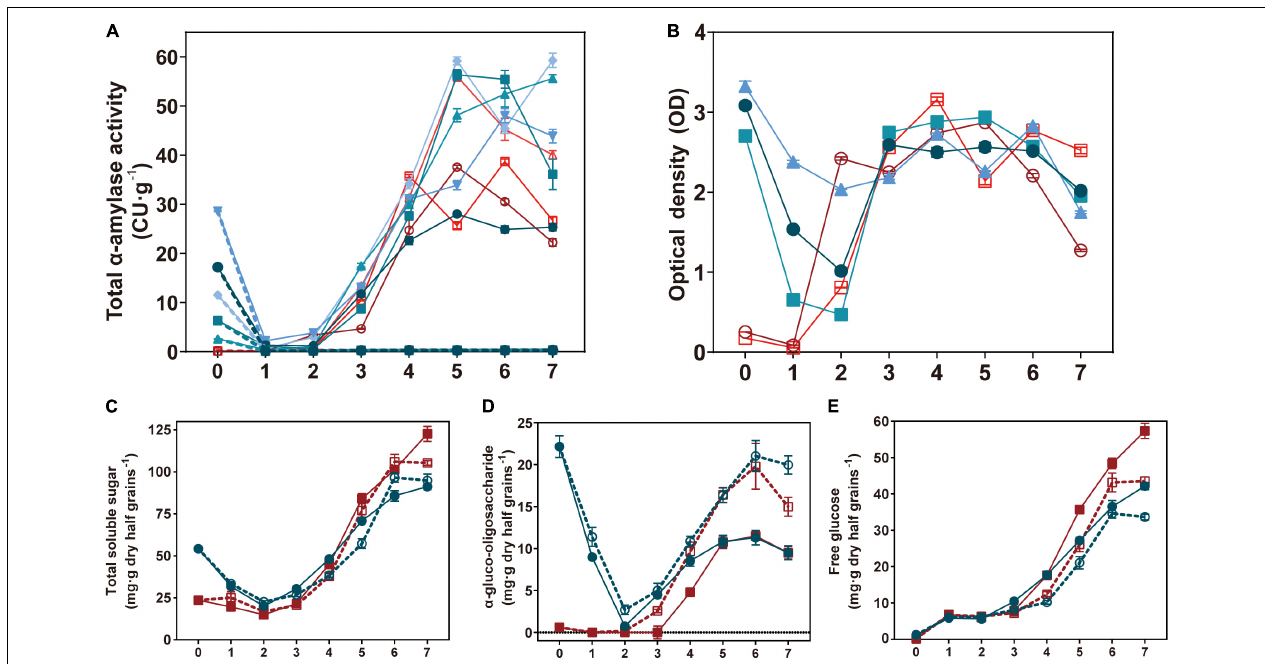
FIGURE 6 | Effects on α -amylase activity TaAMY1 accumulation and total soluble sugar composition during germination. Total α -amylase activity (A) , TaAMY1 ELISA test (B) , total soluble sugar (C) , α -gluco-oligosaccharide (D) , and free glucose (E) were measured in half grains during germination. For (A,B) , different blue and red colors indicated five Bx17A1OE lines and negative controls, respectively. Plain and dash lines indicated absence or presence of acarbose. In (C–E) , the average of five Bx17A1OE lines (blue) and three negative (red) half grains during germination in the absence (plain) and presence of acarbose (dash) (1.5 mM) for 7 days. Values are expressed as mean ±